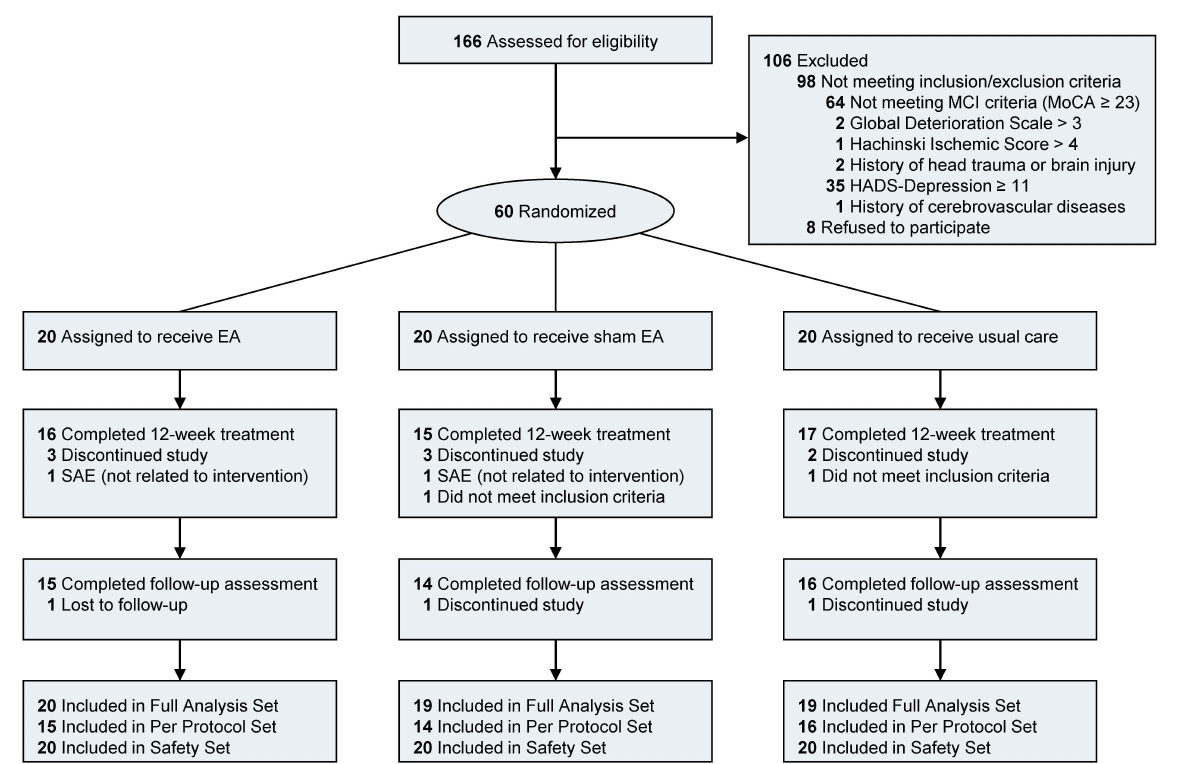
Figure 2. Flow diagram of participants in the pilot trial of EA for mild cognitive impairment. Number of participants not meeting each inclusion/exclusion criteria were counted individually. There were six participants who did not meet the MCI criteria with higher HADS-D than 11. One participant did meet the MCI criteria with GDS higher than 3. Two serious adverse events (SAE) occurred. Both were definitely not related to interventions. Two participants did not meet the inclusion criteria after the randomization. Thus, they were excluded from the Full Analysis Set